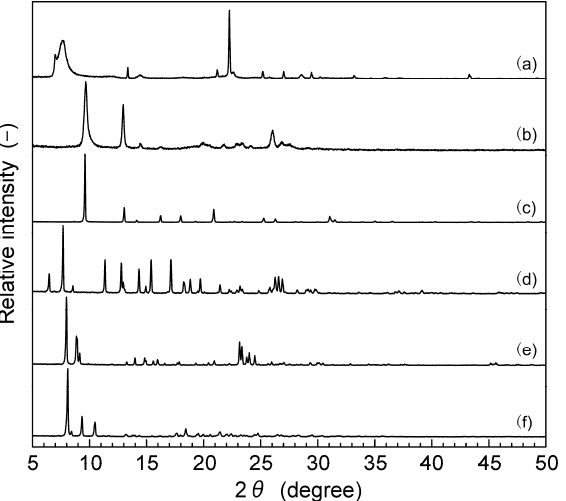
Figure 3. XRD patterns of all-silica ( a ) BEA, ( b ) CDO, ( c ) CHA, ( d ) DDR, ( e ) MFI, and ( f ) STT-type zeolite particles synthesized in this study.